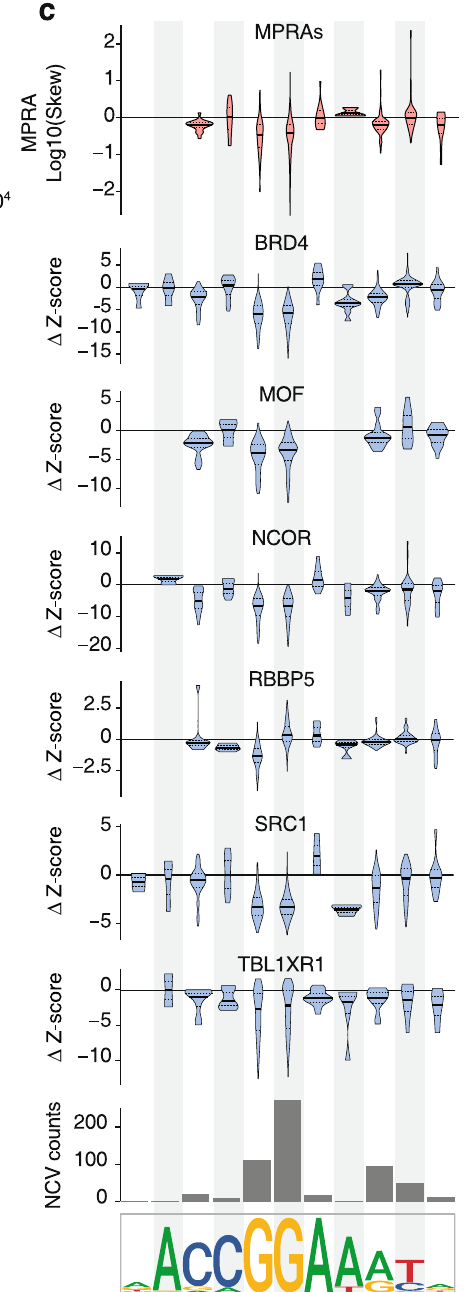
Fig. 4 | NCVs derived from highly prevalent mutational processes affect tran- scriptionalactivityandCOFrecruitment. a MPRAand CASCADE validation rates for TFA-BT NCVs associated with different mutational signatures. Only mutational signaturesassociatedwith fi veormoreNCVsinMPRAactiveregionsinatleastone cell line are shown. Gray cells indicate mutational signatures with less than 5 NCVs in MPRA active regions in the indicated cell line. The right heatmap depicts the fractionofTFA-BTNCVsineachmutationsignaturethatareassociatedwithaltered COFrecruitment. b MPRAvalidationrateforNCVsassociatedornotwithultraviolet (UV)-light mutational signature in SK-MEL-28 cells. UV-light + NCVs ( n =967), UV- light – NCVs ( n =161). Error bars indicate the standard error of a proportion.